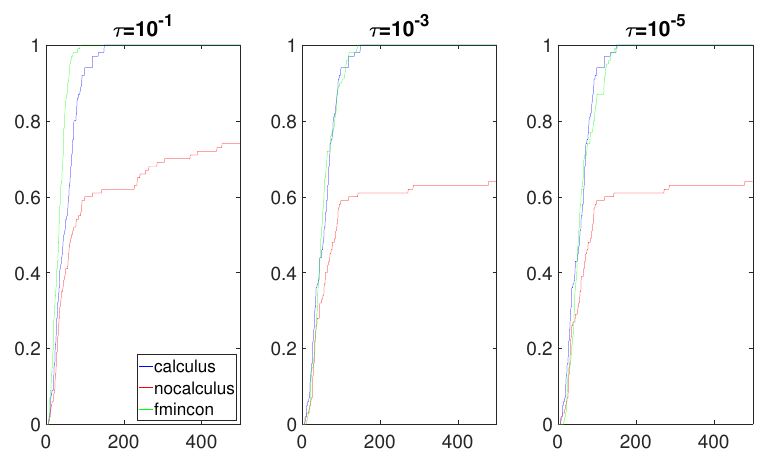
Figure 8. Data profiles when F = f 1